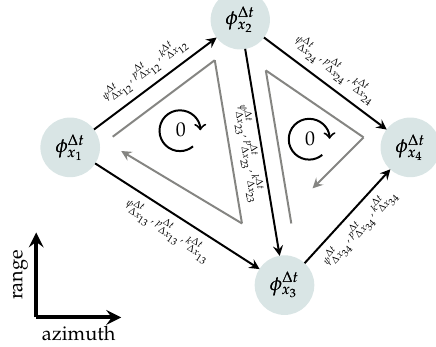
Figure 1. Spatial Delaunay triangulation for an example of four pixels. To ensure that the solution is rotation-free, the sum of the unwrapped phase gradients in one triangle has to be